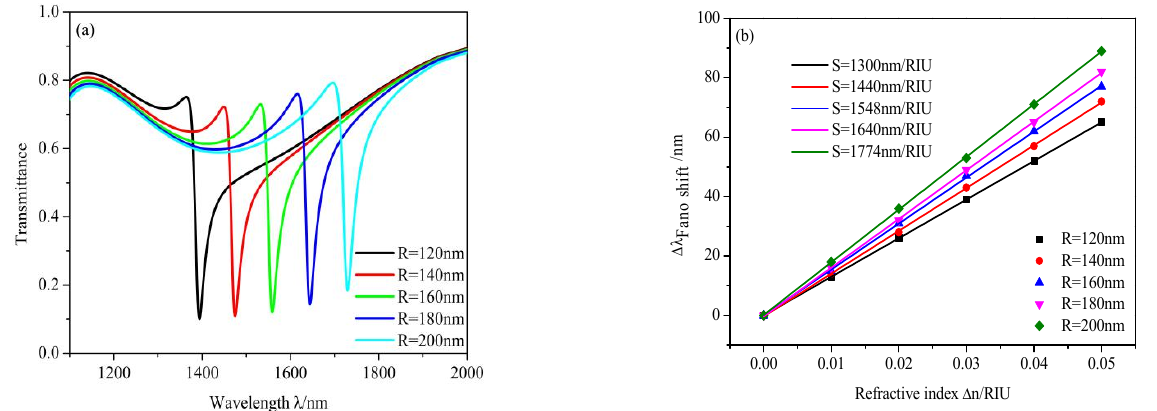
Figure 8. ( a ) Transmission spectra of the different radius of the racetrack ring resonator R ; ( b ) linear fitting of the sensitiv- ity.